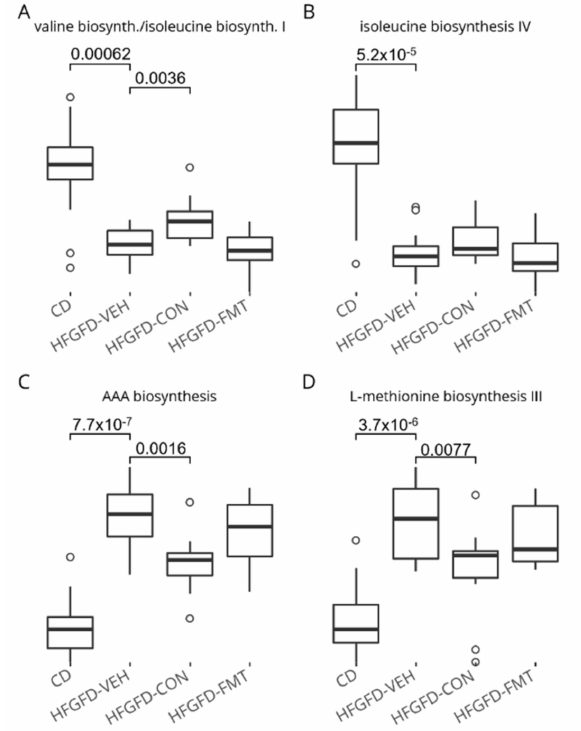
Figure 5. Predicted BCAA ( A , B ), AAA ( C ), and Methionine ( D ) biosynthesis pathways in the cecum of NASH rats. Statistically significant differences are depicted above boxplots. HFGFD-VEH: group of NASH rats receiving sham gavage (vehicle); HFGFD-CON: group of NASH rats receiving the 9-strain bacterial consortium daily; HFGFD-FMT: group of NASH rats receiving fecal microbiota transplantation from control lean rats (1 × transplantation followed by sham